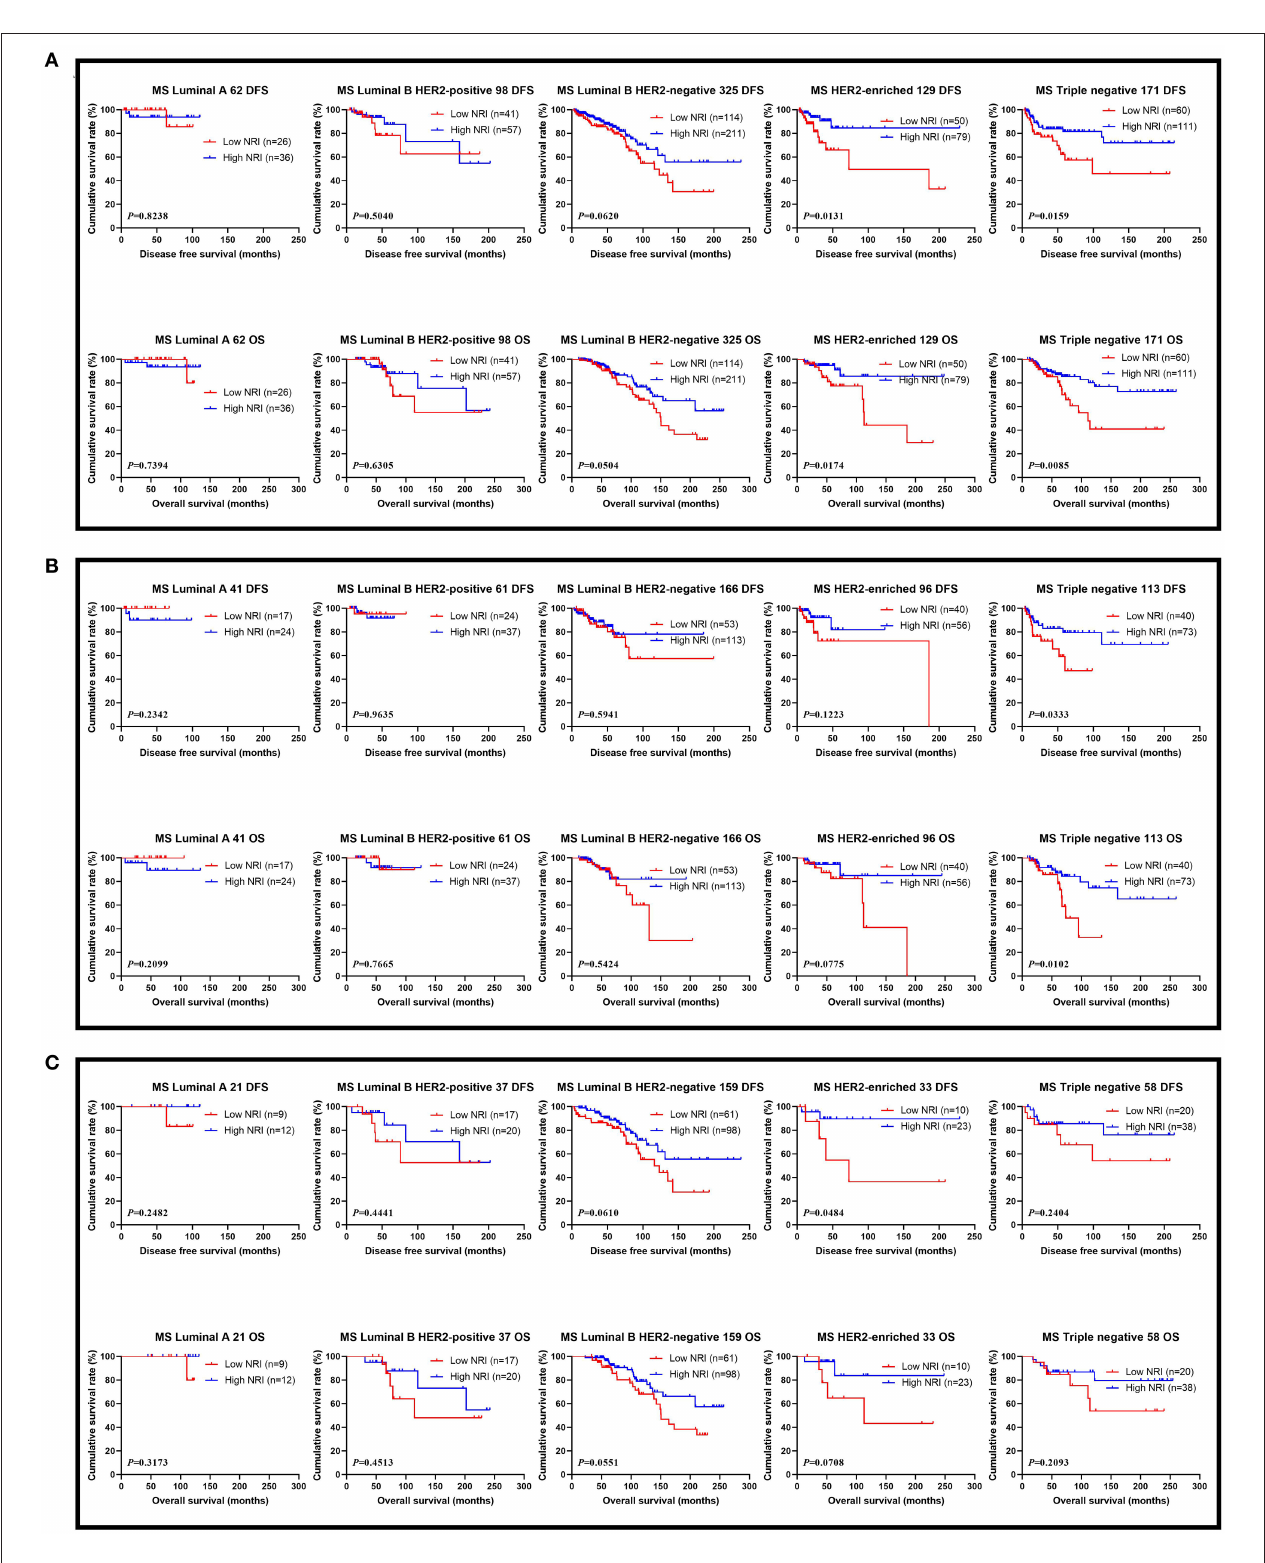
FIGURE 3 | DFS and OS for the NRI of breast cancer patients in different molecular subtypes. (A) DFS and OS for the NRI of breast cancer patients in different molecular subtypes in all patients; (B) DFS and OS for the NRI of breast cancer patients in different molecular subtypes in NACT group; (C) DFS and OS for the NRI of breast cancer patients in different molecular subtypes in non-NACT